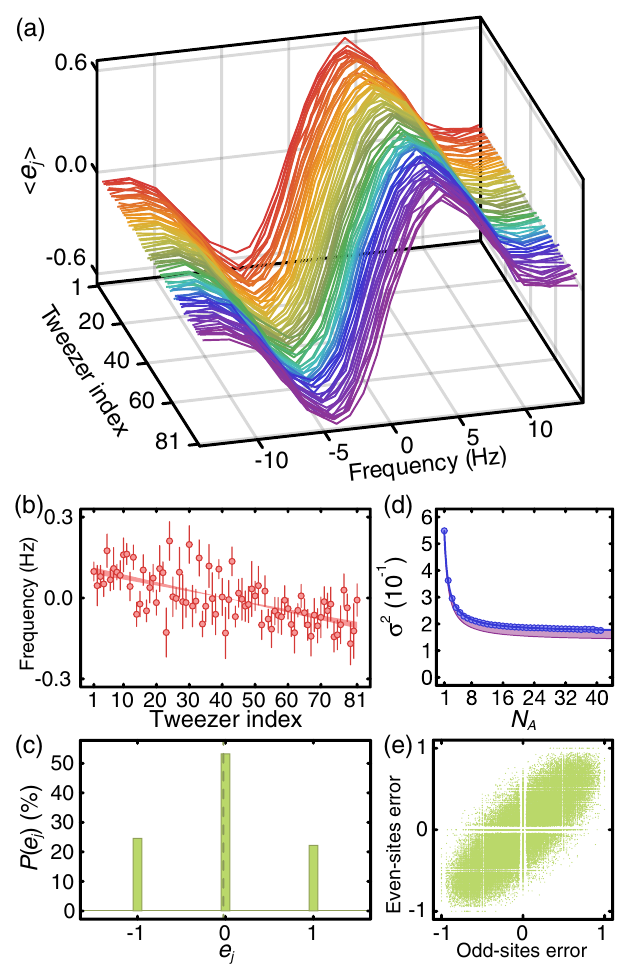
FIG. 2. Site-resolved error signal. (a) Repetition-averaged single-tweezer error signal h e as a function of frequency offset j i measured with an in-loop sequence. (b) Fitted zero crossings as a function of tweezer index for our usual interrogation trap depth h × 3 . 43 kHz (circles). Solid of U 1 ¼ 245 ð 31 Þ E , where E r r ¼ lines correspond to theory predictions, with the shaded area resulting from systematic uncertainty in trap depth (Appendix E). (c) Ternary probability distribution for e for a selected tweezer. j The vertical dashed line shows the mean. (d) Variance of the error signal as a function of atom number, calculated through post- selection. The solid line is a fit with a 1 =N function plus an A offset. The purple region is a MC simulation. (e) Plot of correlations between the error signals of even and odd